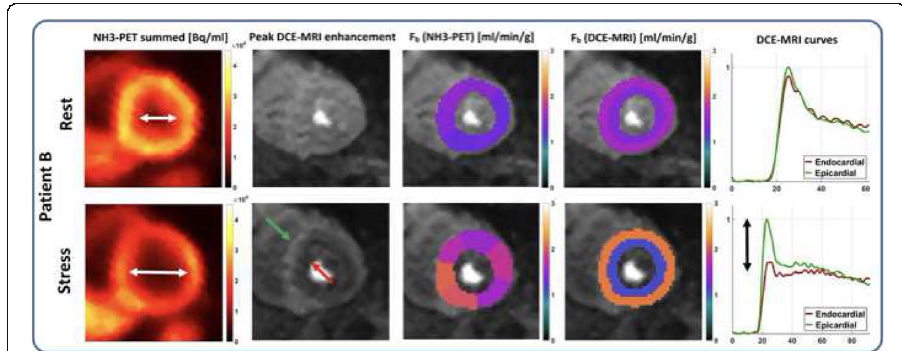
Fig. 4 Hybrid PET/MRI myocardial perfusion assessment in a patient with hypertrophic cardiomyopathy. The apparent dilatation of left ventricular cavity during adenosine challenge (first column) is caused by a stress- induced subendocardial hypoperfusion as demonstrated by MRI MPI (column two to five). (Reprinted with permission from Kunze KP, Nekolla SG, Rischpler C, et al. Myocardial perfusion quantification using simultaneously acquired 13NH3-ammonia PET and dynamic contrast-enhanced MRI in patients at rest and stress. Magn Reson Med. 2018;00:1 – 14.